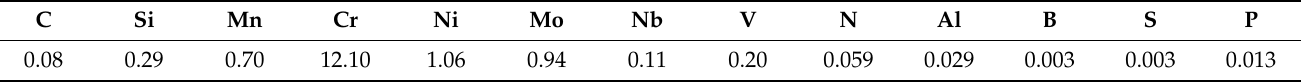
Table 1. The chemical composition of 12Cr F/M steel, wt. %.